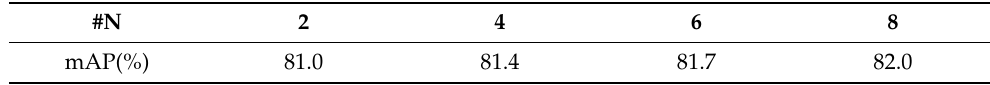
Table 1. The effect of support frame number